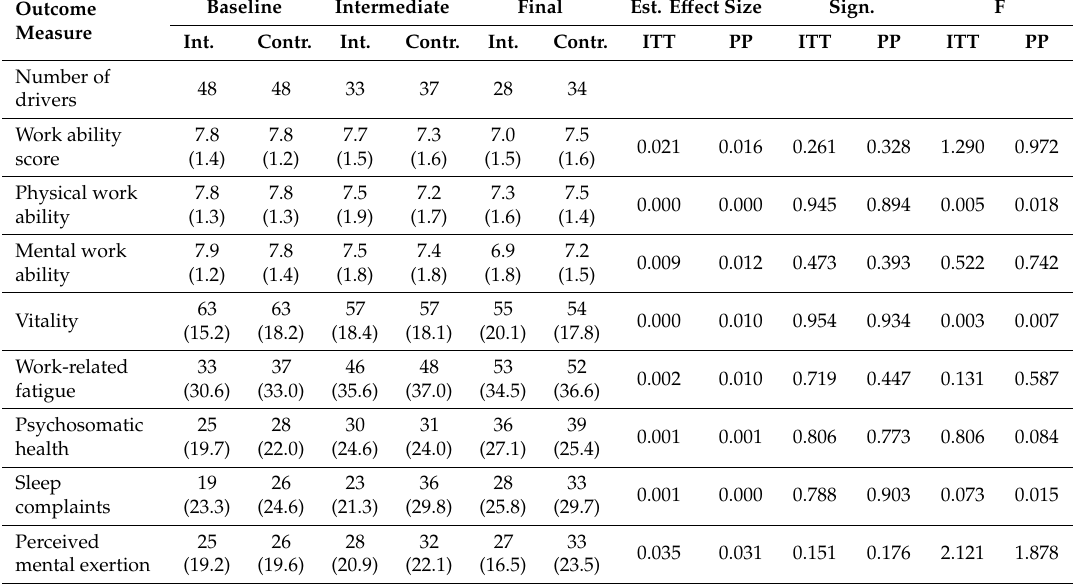
Table 2. Values (mean ± SD) for the primary and secondary outcome variables for the intervention and control group at the baseline, intermediate, and final measurement, based on the intention-to-treat protocol. The estimated e ff ect size, significance ( p -value), and F-value of the ANCOVA analyses of both analyses are shown in the right columns. Both the intention-to-treat and the per protocol analysis results are